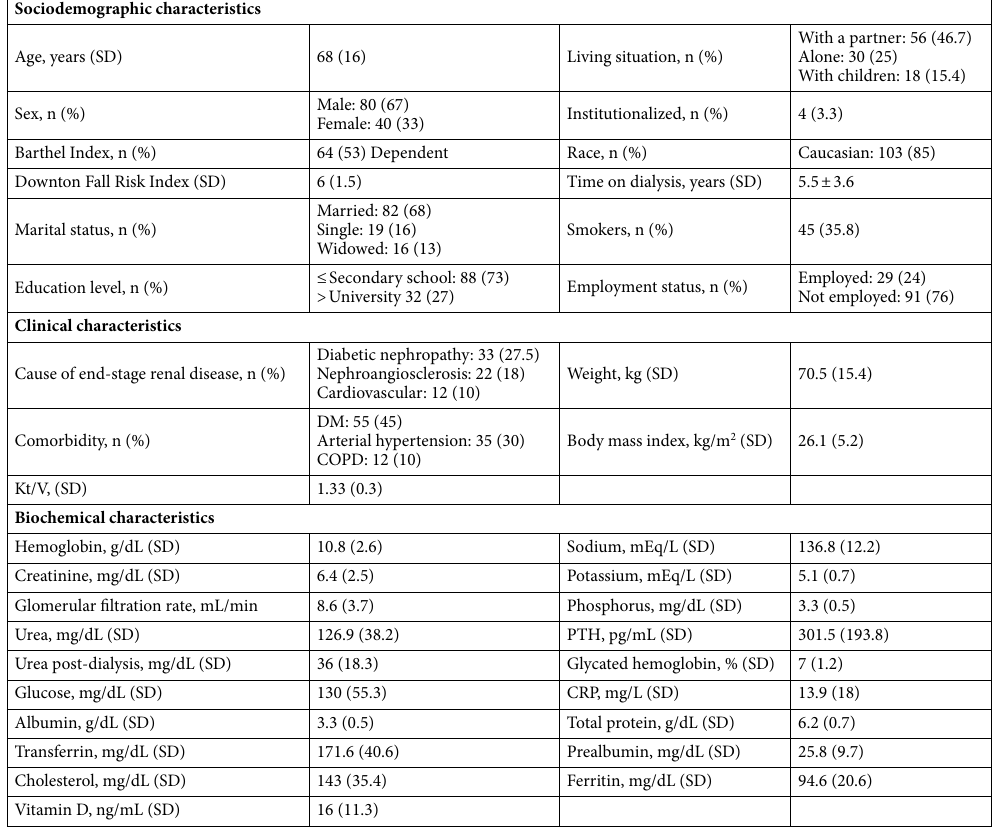
Table 1. Sociodemographic and clinical characteristics of the total population. Data are expressed as mean ± standard deviation for normal data. DM Diabetes Mellitus, COPD chronic obstructive pulmonary disease, CRP C-reactive protein, PTH Parathyroid hormone.